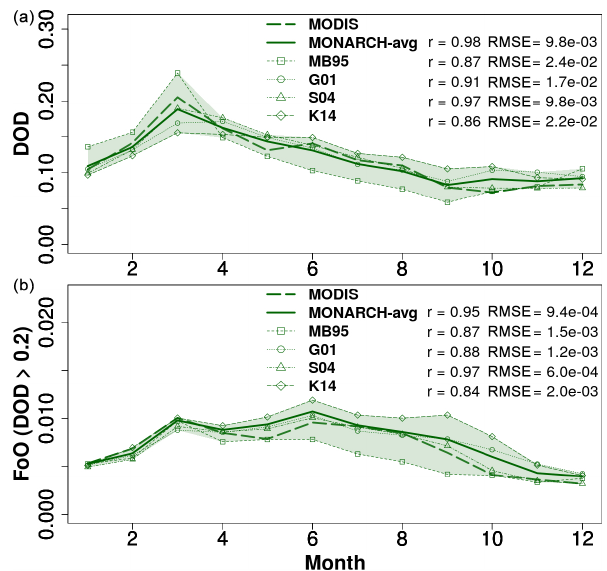
Figure 7. Globally averaged monthly global DOD coarse (a) and FoO of DOD > 0 . 2 (b) for MODIS (dashed green line) and MONARCH (DOD coarse all-sky co-located with MODIS obser- vations) (green solid line). The shading indicates the range of DOD coarse across the four MONARCH experiments, which are also shown. Pearson correlation coefficients (r) and RMSE are given in the figure for both the experimental average as well as the individual